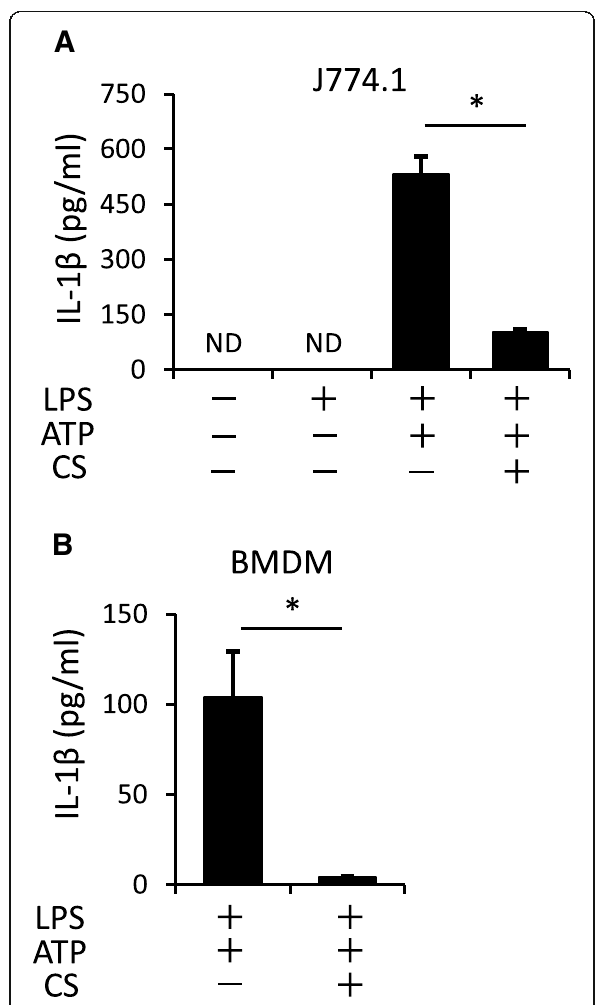
Fig. 3 Cyclic stretch inhibits ATP-stimulated IL-1 β secretion in LPS-primed macrophages. The murine macrophage cell line J774.1 ( a ) and mouse bone marrow-derived macrophages (BMDM) ( b ) was primed with 100 ng/mL of E. coli LPS for 4h followed by stimulation with 1mM ATP for 2 h in the continuous presence of LPS. Cells were exposed to cyclic stretch of 20% elongation at a frequency of 10cycles/min for the first 2h after the addition of LPS. Significance is indicated (* P <0.05 significantly different from the positive control). CS, cyclic stretch. ND, not